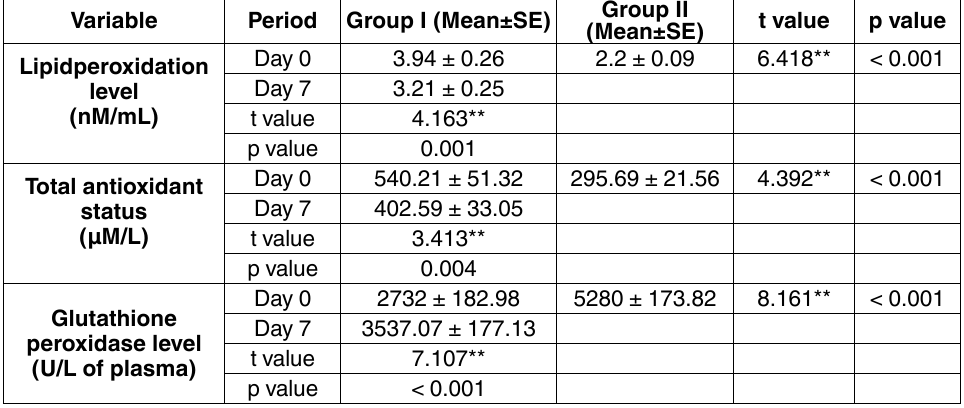
table 1 . Oxidative stress parameters of dogs with HGE and apparently healthy dogs